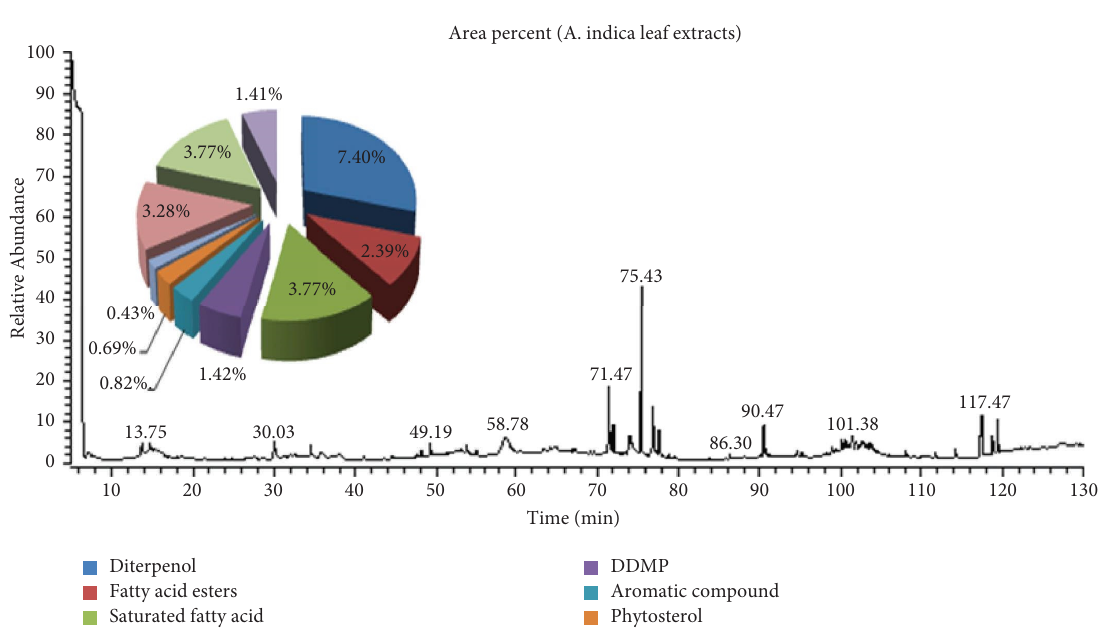
Figure 3: GC-MS profling of K. senegalensis stem bark and A. indica leaves